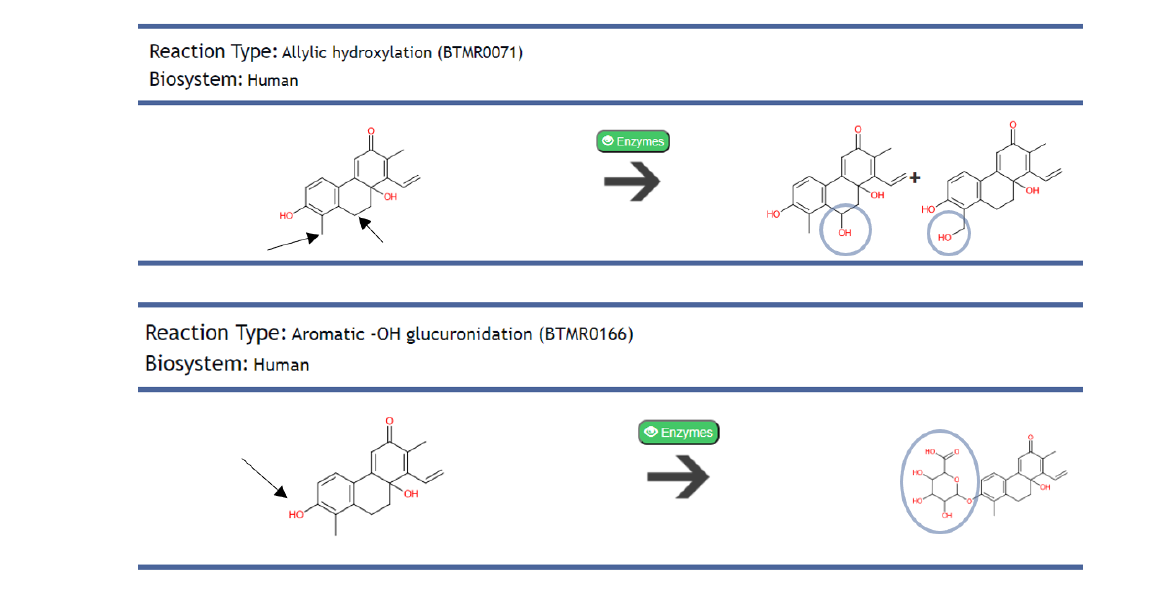
Figure 10. Showing HTML documents containing the results for biotransformation prediction of an AMNP (juncuenin D). The first line illustrates the structure of the parent compound (left side of the reaction), the enzymes (Cytochrome P450) that may likely act on it, and the products of the reactions (right side of the reaction) during phase 1 metabolism. The second line illustrates the parent structure (left side of the reaction), the enzymes (UDP-glucuronosyltransferase) that may likely act on it, and the predicted metabolite (right side of the reaction) during phase 2. Each of the circles represents the points of transformation, while the arrow points to the atom that is transformed.